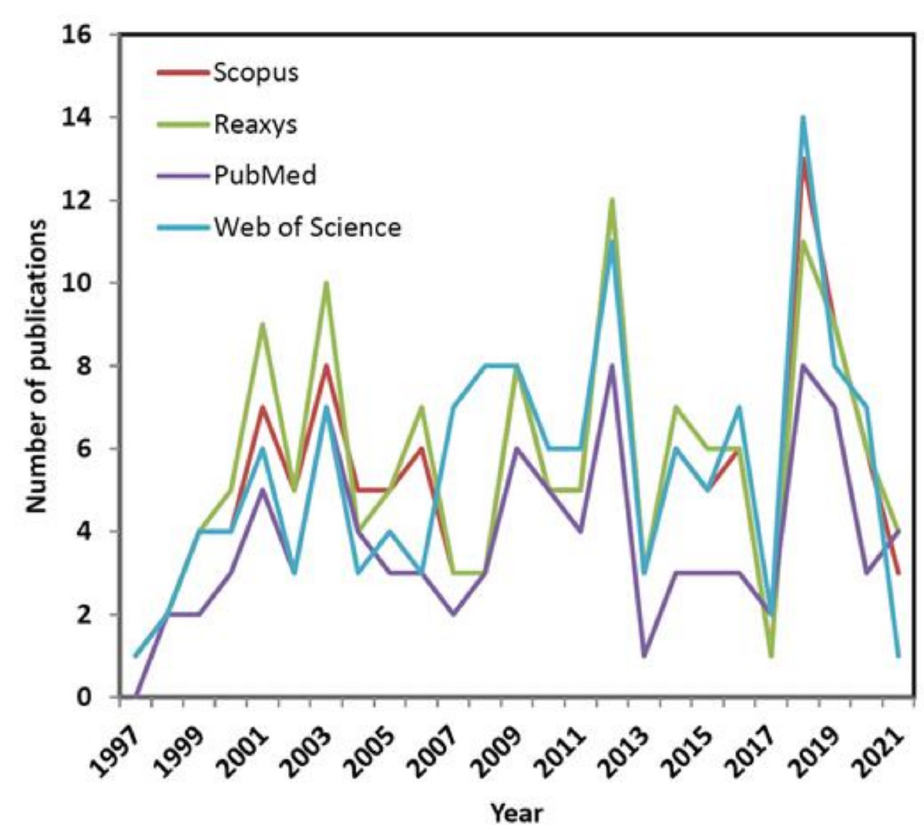
Figure 3. Trends in the number of publications, where ‘4D QSAR’ was queried in the paper’s title, abstract or keyword from 1997 to